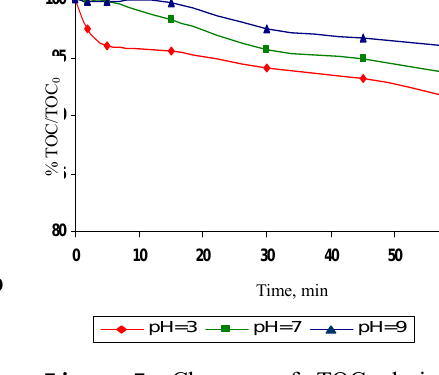
] = 5.64 mg/L; [4NCB] 3 o